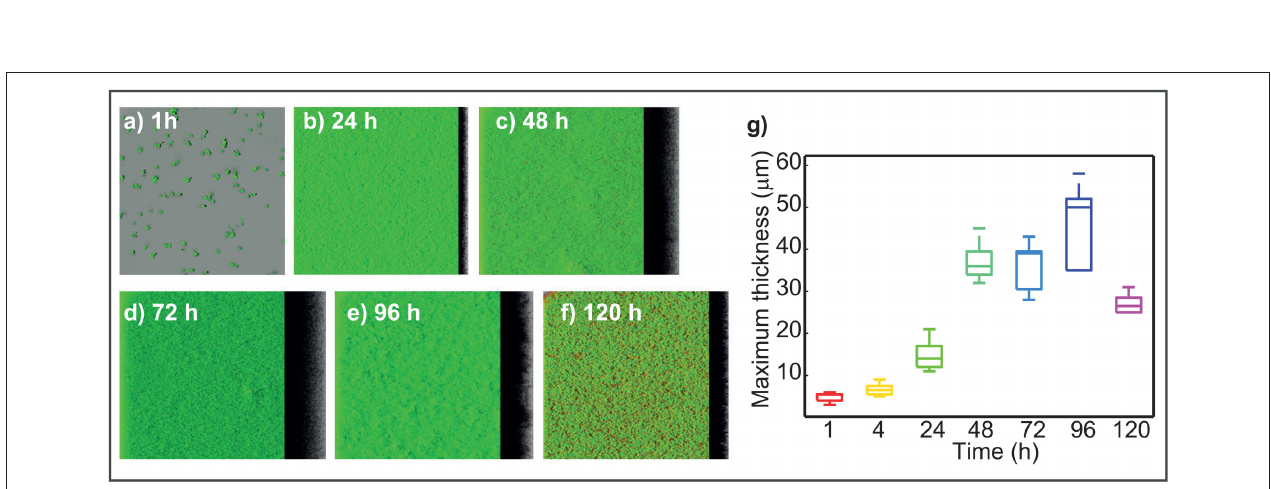
FIGURE 2 | Dynamics of L1A1 L. monocytogenes biofilms during life cycle. (a–f) Present the three-dimensional reconstruction of the CLSM images captured at different times of the biofilms life cycle. (g) Presents the measured maximum thickness (mMxT) vs. time. Box plots represent the variability of maximum thickness over the different replicates. On each box, the central mark indicates the median, and the bottom and top edges of the box indicate the 25 and 75th percentiles, respectively. The whiskers extend to the most extreme data points not considered outliers. The figure shows the median of MxT value increases with time up to 96 h. Maximum median value is of around 50 µ m. After that MxT values decrease revealing a massive detachment episode between 96 and 120 h.